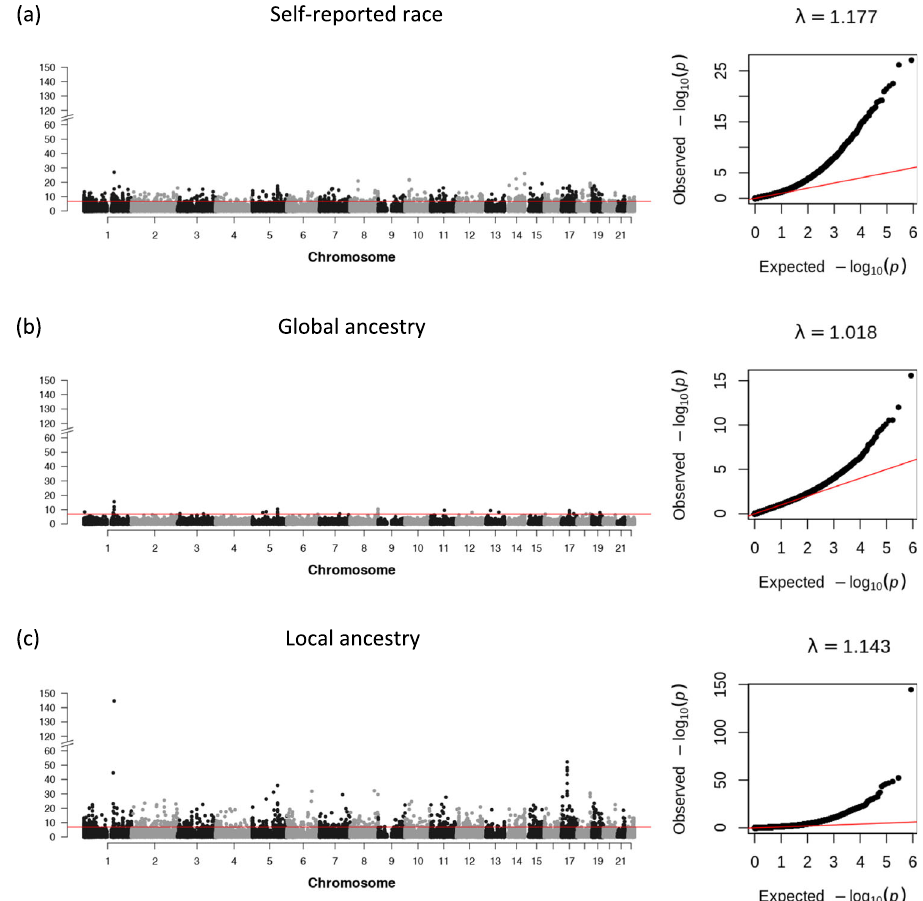
Fig. 3 Manhattan and QQ plots for epigenome-wide association study (EWAS) of ancestry variables in the Veterans Aging Cohort Study (VACS) discovery group. The EWAS identi fi ed ( a ) 708 CpGs (genomic in fl ation λ = 1.18) signi fi cantly associated with self-reported race ( N = 527), ( b ) 30 CpGs (genomic in fl ation λ = 1.02) signi fi cantly associated with global ancestry ( N = 478), and ( c ) 1,284 CpGs (genomic in fl ation λ = 1.14) signi fi cantly associated with local ancestry ( N = 478), respectively. Self-reported race was extracted from self-reported survey data. Global ancestry was estimated with ADMIXTURE. Local ancestry was estimated using RFMix. Yoruba in Ibadan, Nigeria (YRI) and Utah Residents (CEPH) with Northern and Western European Ancestry (CEU) samples from the 1000 Genomes Project are used as African and European reference panels for global and local ancestry estimations. The vertical axes across three panels are made on the same scale for